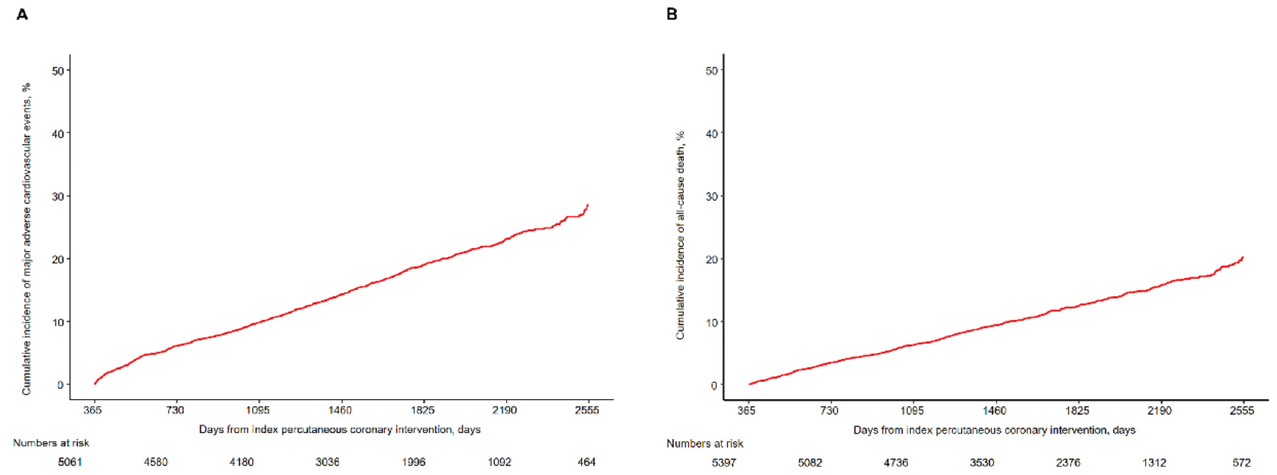
Figure 2. Kaplan-Meier analyses of cumulative incidence of ( A ) major adverse cardiovascular events and ( B ) all-cause death.